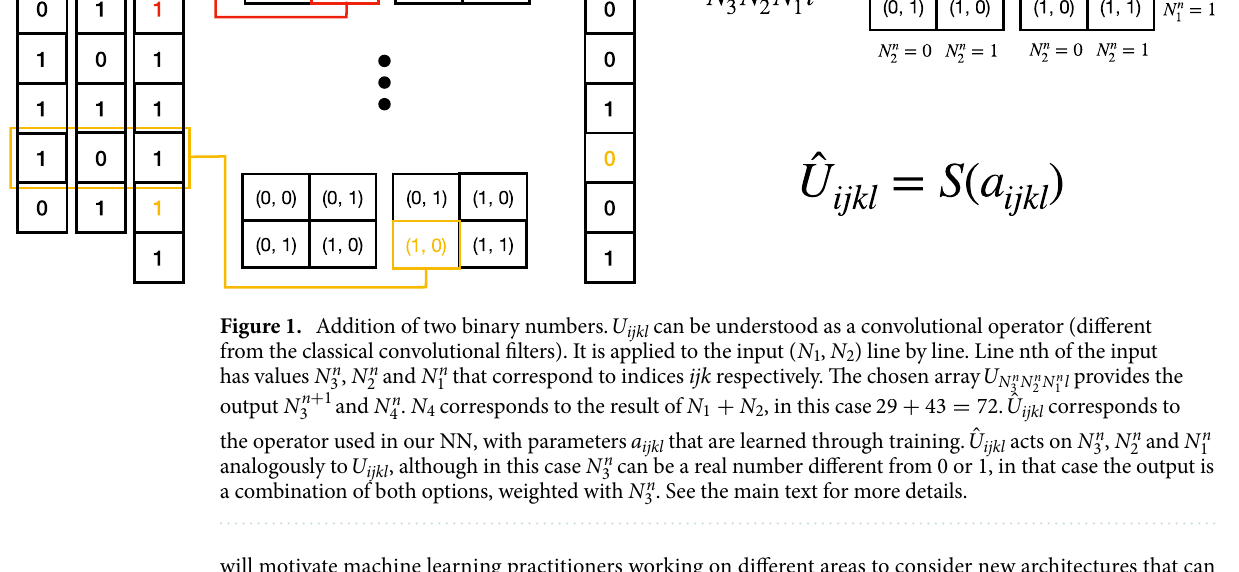
provides the 3 N n 2 N n 1 l 29 + 43 = 72 . ˆ U ijkl corresponds to